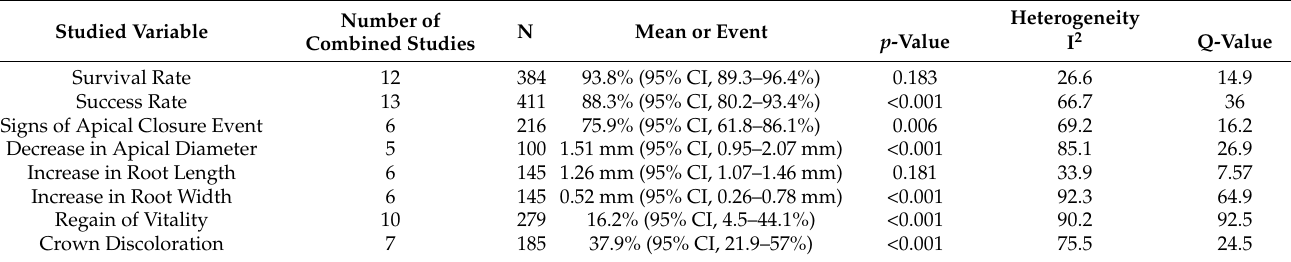
Table 4. Results of meta-analysis for all studied variables.